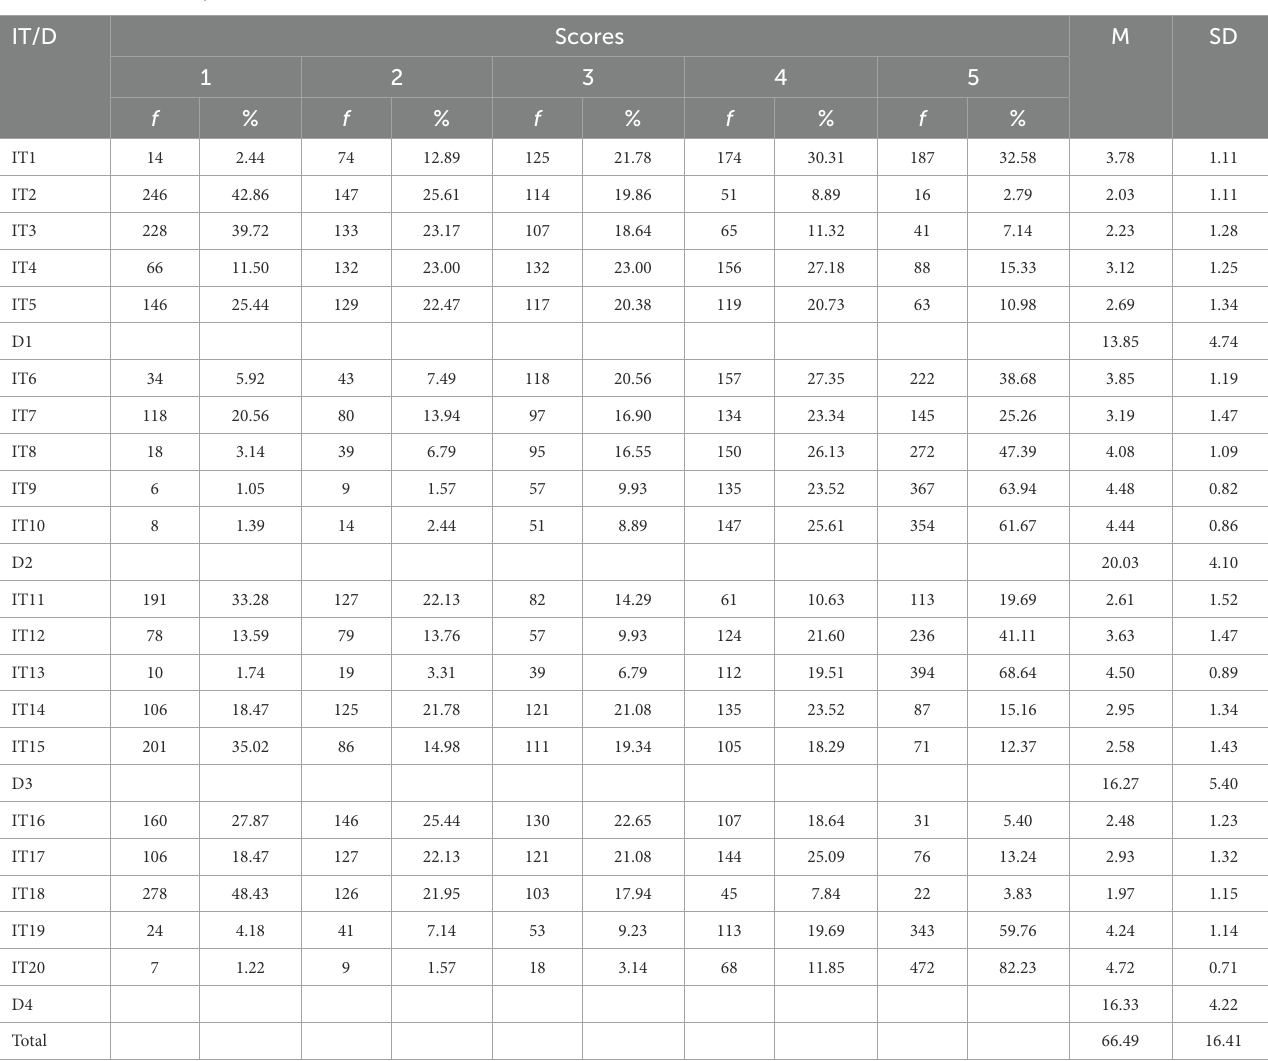
TABLE 2 Results for the questionnaire items and dimensions. IT/D Scores